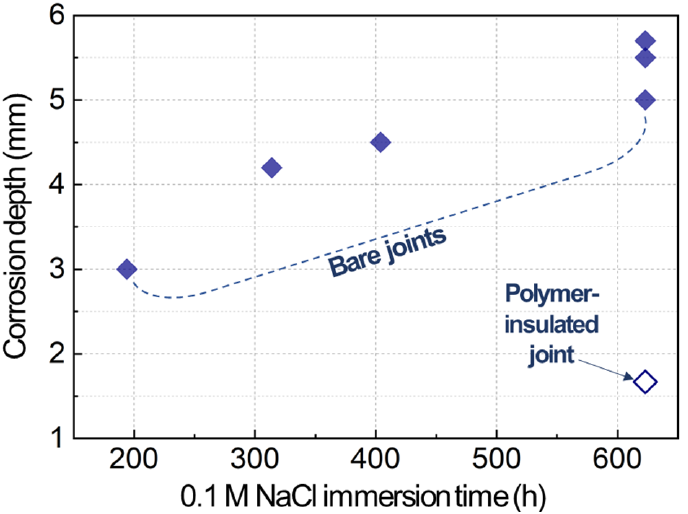
Figure 5. Corrosion depths measured from post-immersion AZ31B shown in Figure 4 as a function of immersion time.